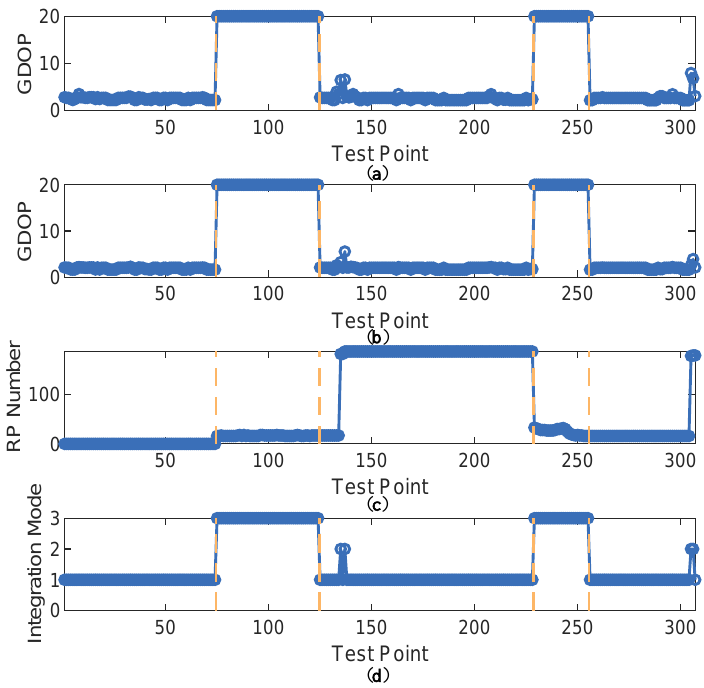
Figure 20. The inputs and output of the fuzzy inference system at Site 2: ( a ) GDOP of GPS-only mode; ( b ) GDOP of GPS + DTMB; ( c ) the number of RPs within constraint range; and ( d ) integration Mode.